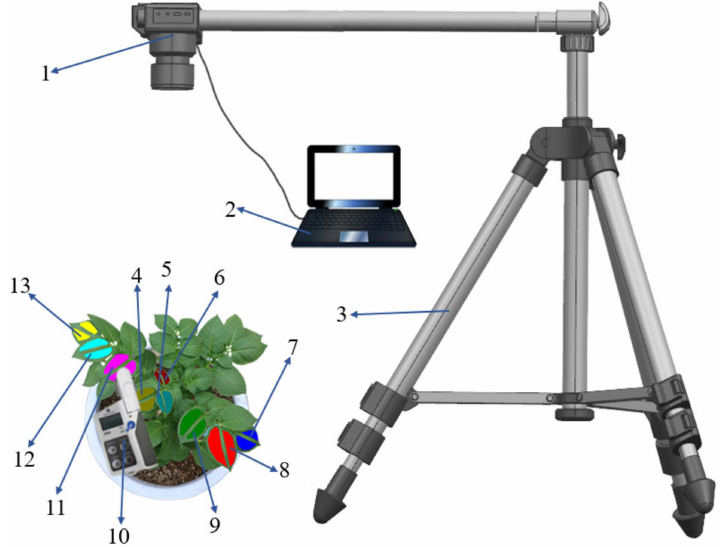
Figure 1. Schematic diagram of the image acquisition system. Note: 1, 2, 3, 4, 5, 6, 7, 8, 9, 10, 11, 12, and 13 represent the EOS 760D camera, laptop, tripod, the first leaf at the top of the canopy, the second leaf at the top of the canopy, the third leaf at the top of the canopy, the first leaf at the middle of canopy, the second leaf at the middle of canopy, the third leaf at the middle of canopy, SPAD 502, the first leaf at the bottom of canopy, the second leaf at the bottom of canopy, and the third leaf at the bottom of canopy,